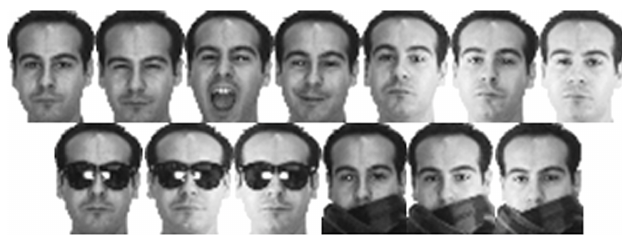
Figure 4. Example images from one subject of the ARdatabase.